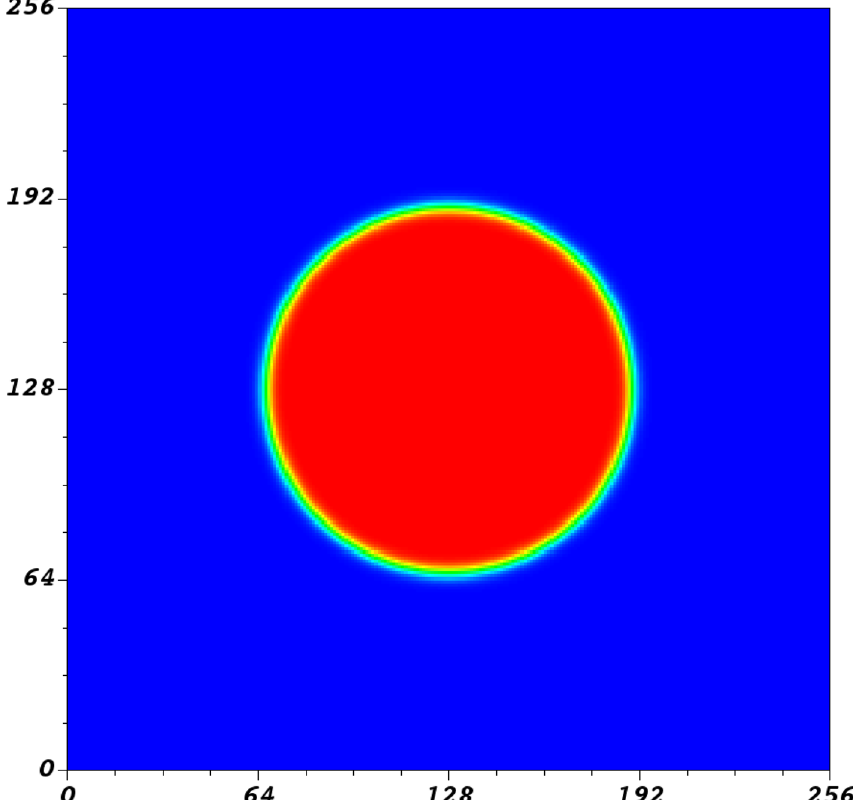
Fig. 4 Distribution of density field at initial moment, τ = 0.3 , T r =